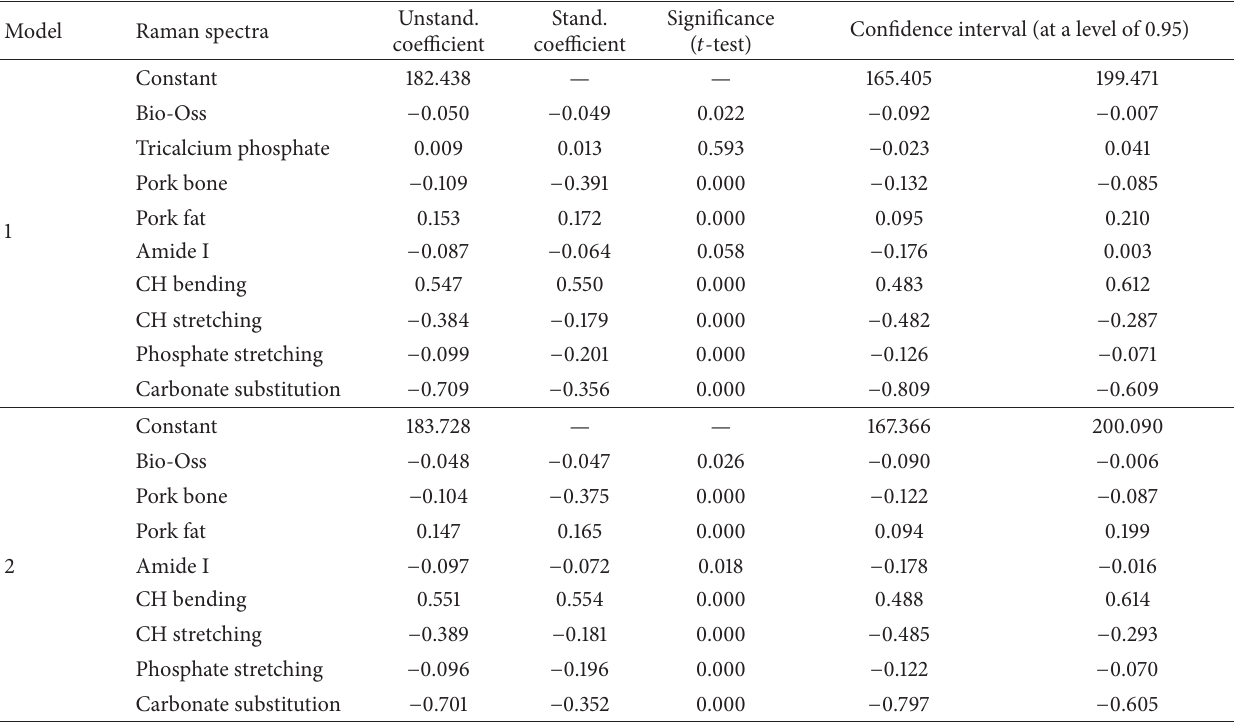
Table 5: Results of the multiple linear